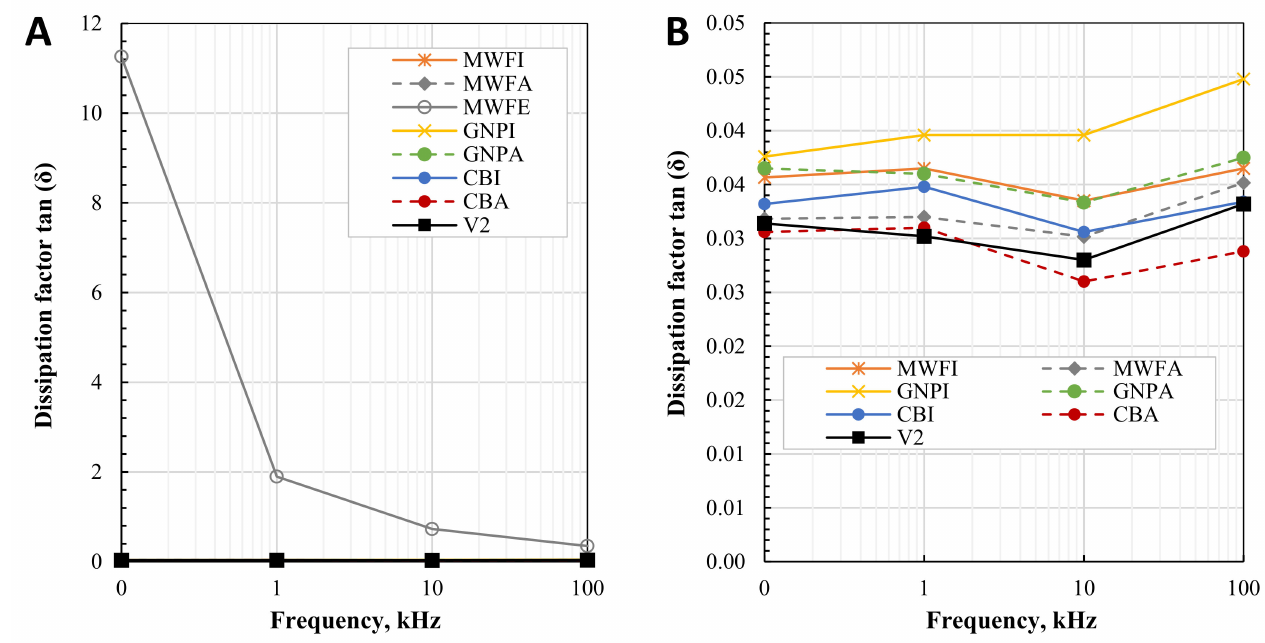
Figure 11. Dissipation factor tan ( δ ) of: ( A ) all composites; ( B ) composites without